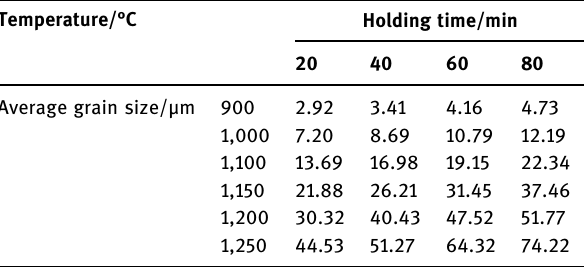
Table 3: Average grain size of austenite under di ff erent process conditions